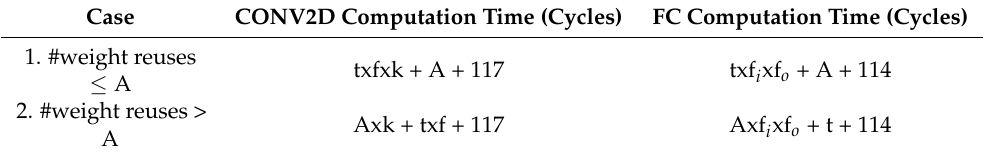
Table 12. Computation time-hand analysis of the CONV2D and the FC operation